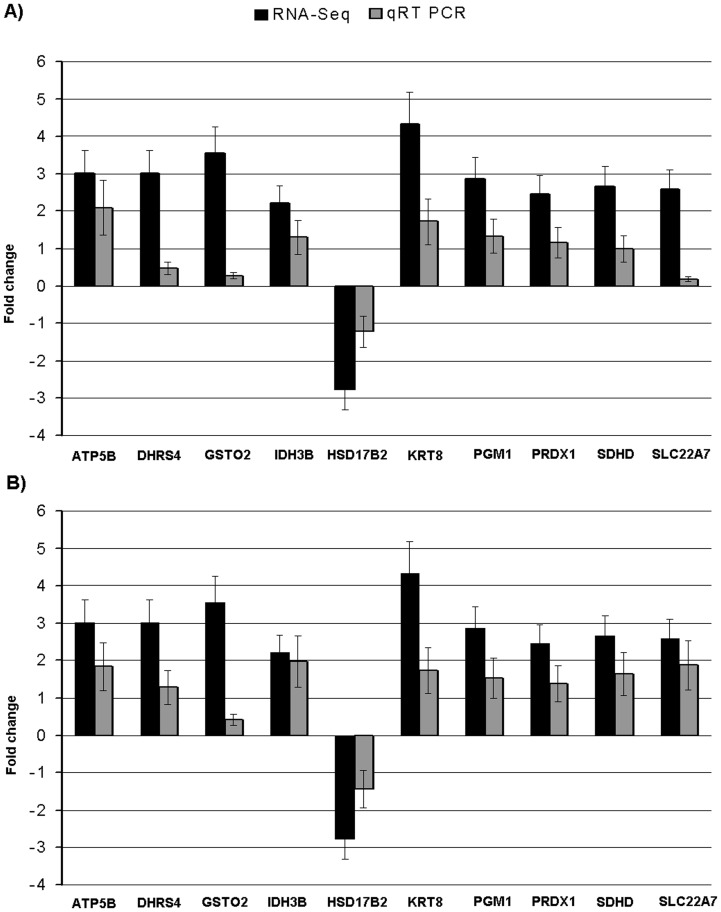
qRT-PCR validations for ten DEGs in liver from boars with divergent skatole levels.The validation was performed using the same RNA samples as used in the RNA deep sequencing (A); new group of boars with divergent skatole levels were created from the remaining 94 boars for the validation of the same DEGs using qRT-PCR (B). Fold change determined via division of high skatole group gene expression value by low skatole group gene expression value.